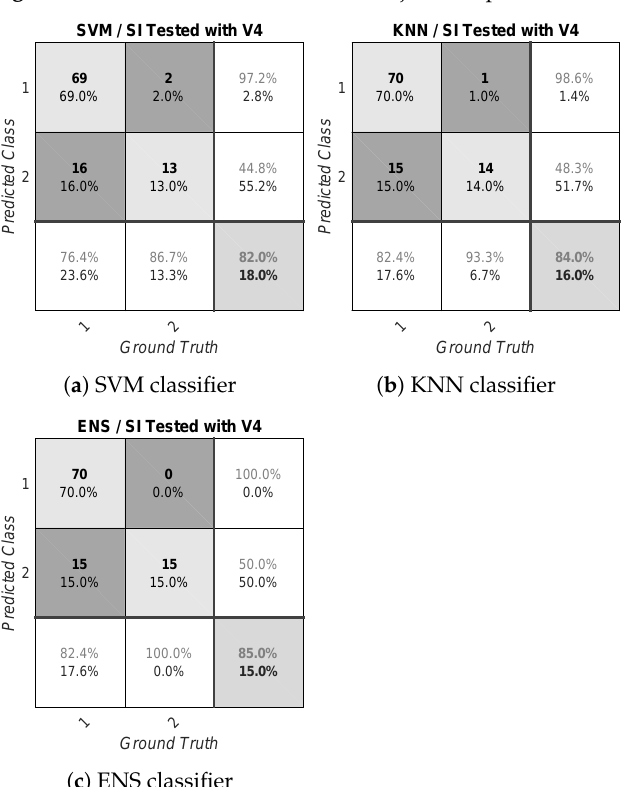
Figure A13. Confusion matrices for a subject-independent model tested with V3.